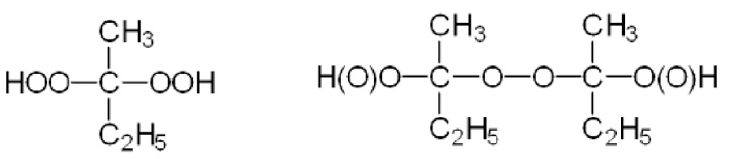
Figure 3. Methyl-ethyl-ketone peroxide formula.